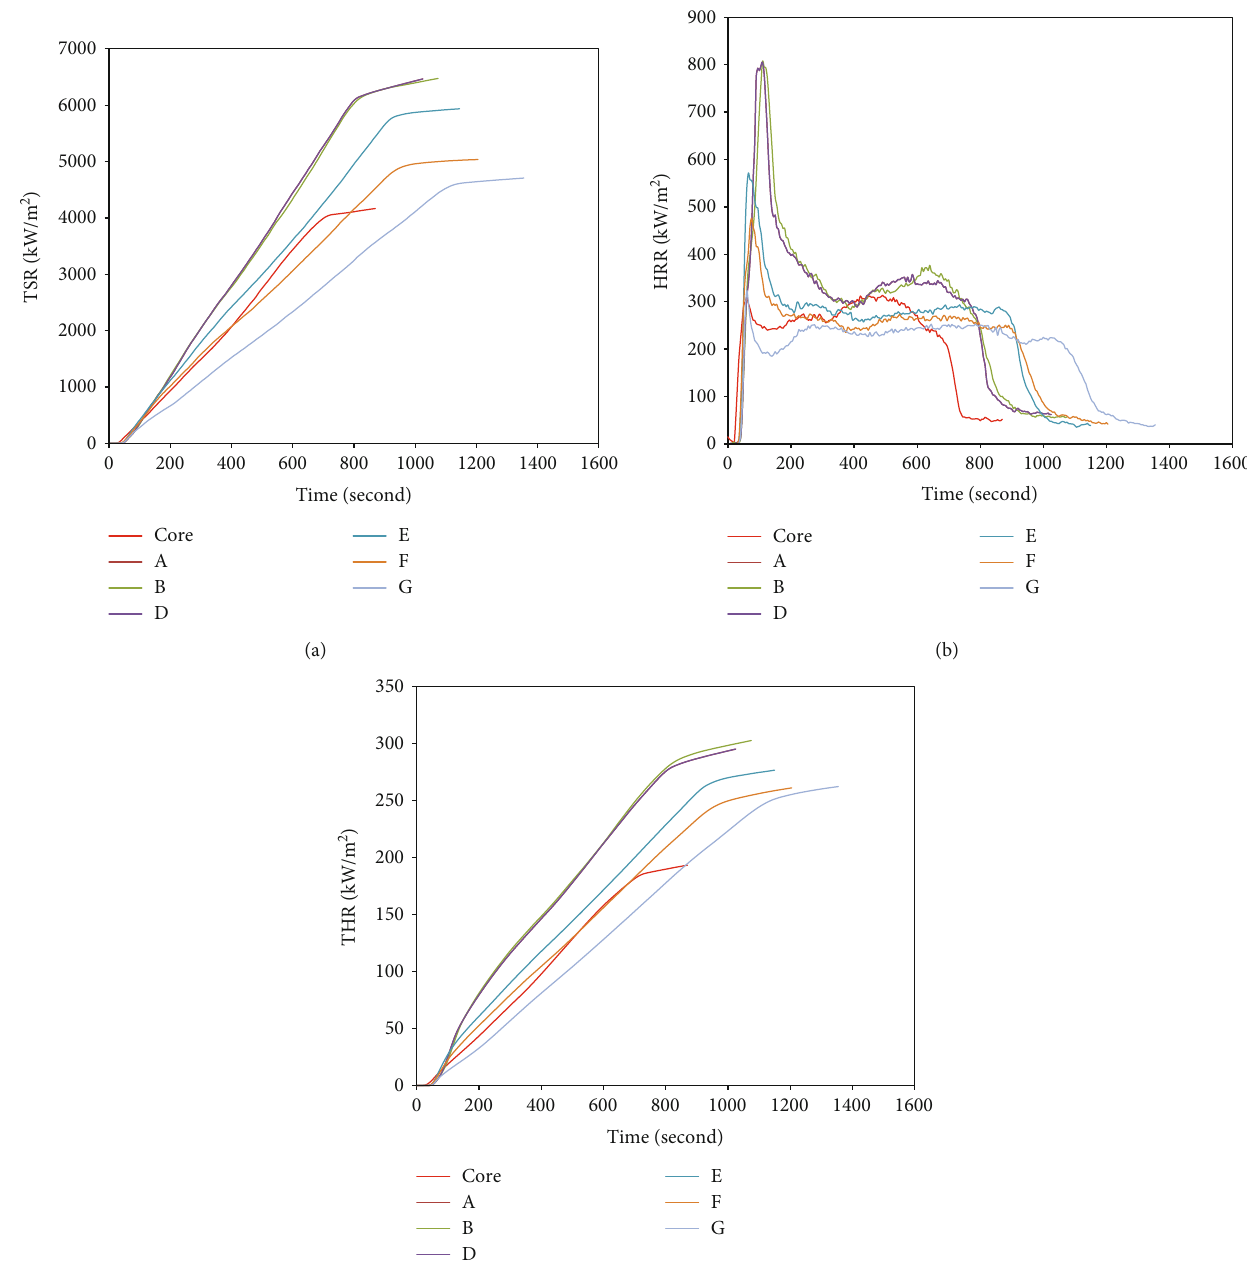
Figure 4: (a) Total smoke rate, (b) heat release rate, and (c) total heat release of the composites with di ff erent talc contents as a function of